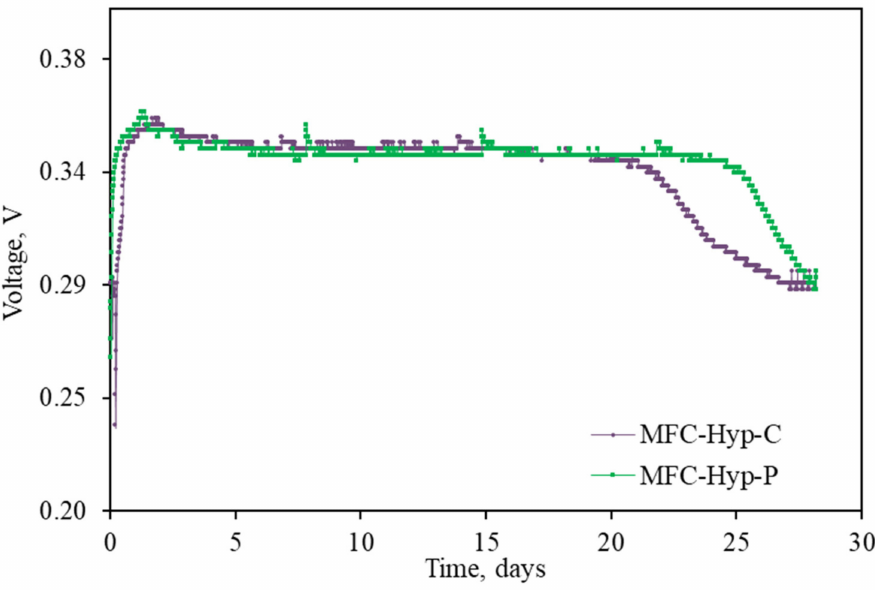
Figure 4. Voltages produced by the MFC-Hyp system in the presence and absence of A. tuberosum , with external resistance of ~1000 Ω : MFC-Hyp-P refers to the system with A. tuberosum and MFC- Hyp-C refers to the control (without A. tuberosum )